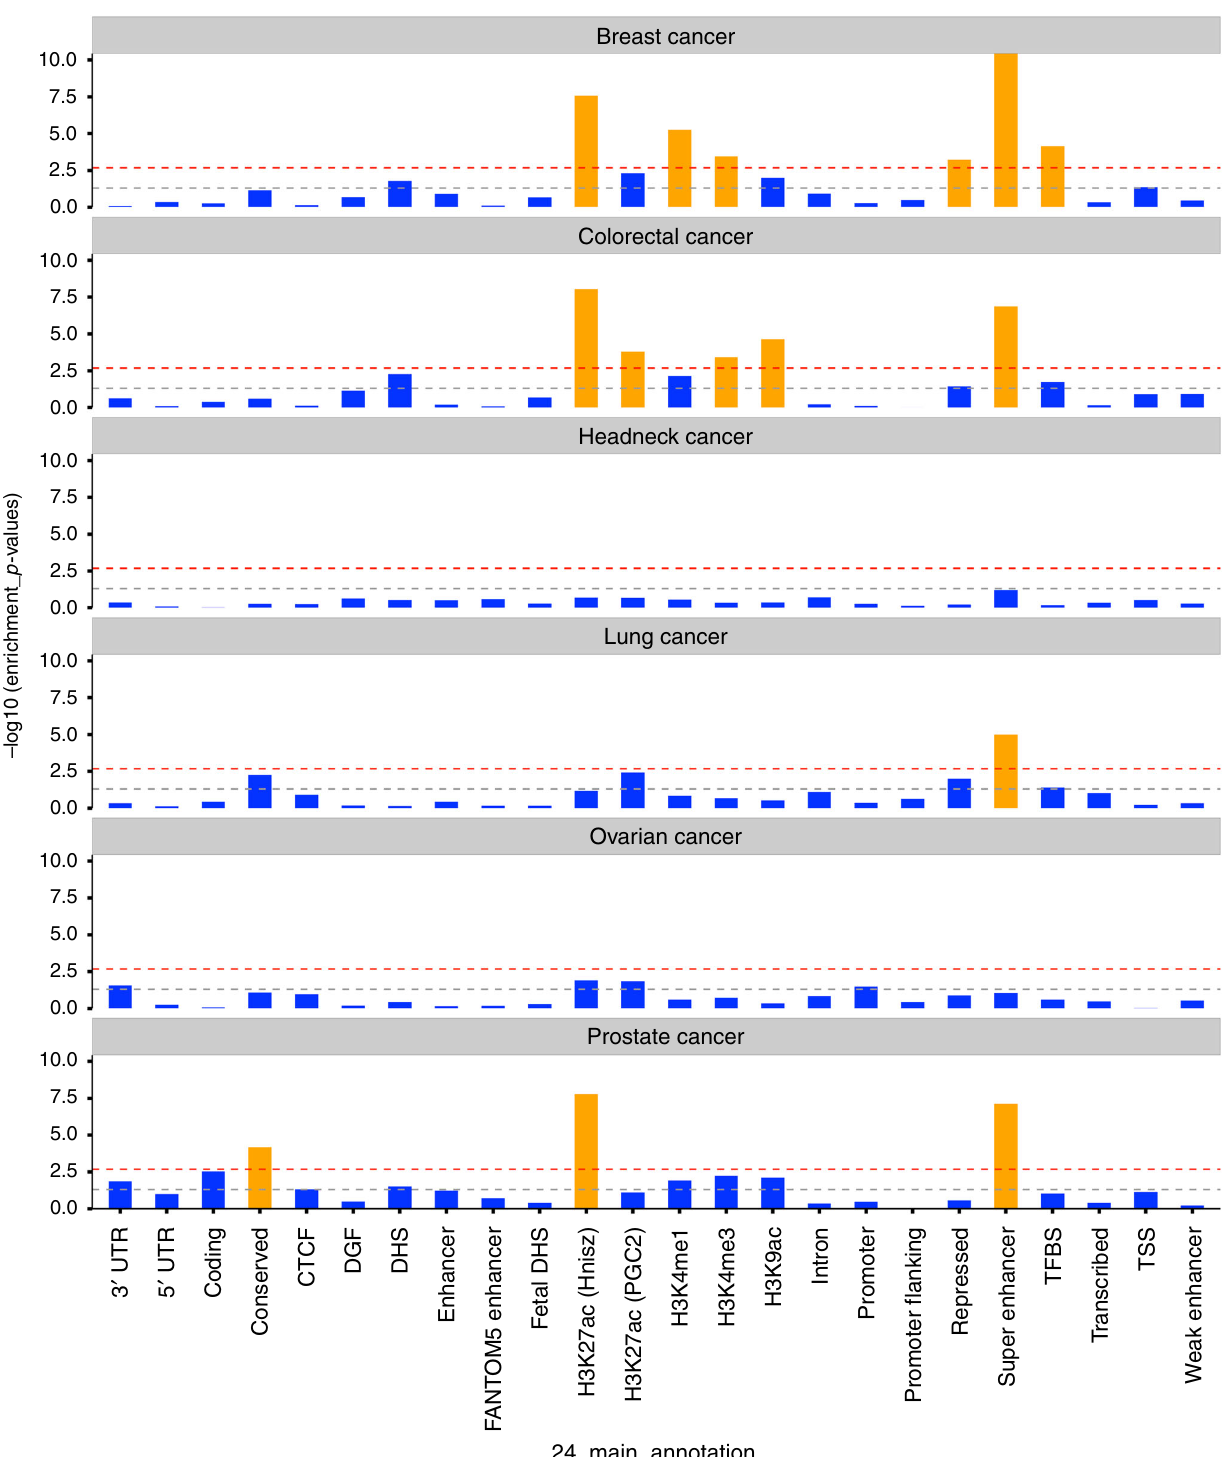
Fig. 5 Enrichment p -values of 24 non-cell-type-speci fi c functional categories over six cancer types. The x -axis represents each of the 24 functional categories, y -axis represents log-transformed p -values of enrichment. Annotations with statistical signi fi cance after Bonferroni corrections ( p < 0.05/24) were plotted in orange, otherwise blue. The horizontal gray dash line indicates p -threshold of 0.05; horizontal red dash line indicates p -threshold of 0.05/ 24. From top to bottom are six panels representing six cancers: breast cancer, colorectal cancer, head/neck cancer, lung cancer, ovarian cancer, and prostate cancer. TSS transcription start site, UTR untranslated region, TFBS transcription factor binding sites, DHS DNase I hypersensitive sites, DGF digital genomic foot printing, CTCF CCCTC-binding